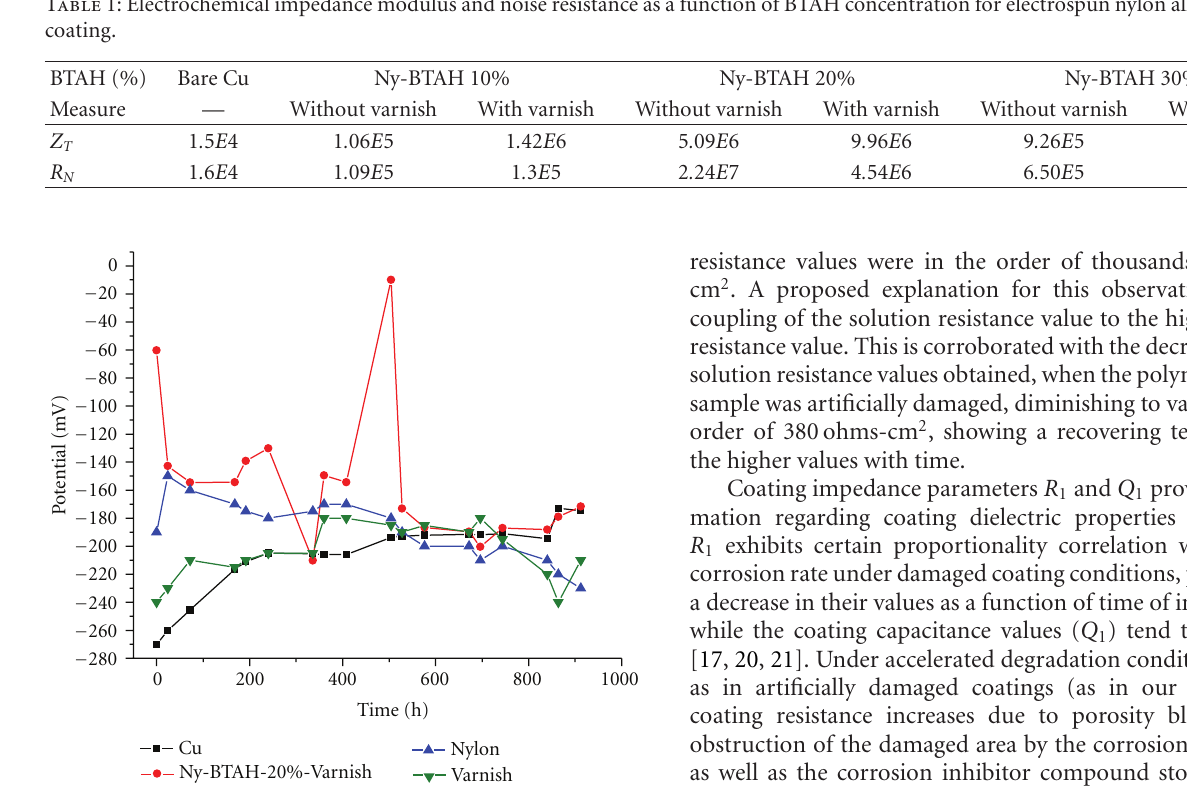
Figure 7: Free corrosion potential as a function of time of immer-